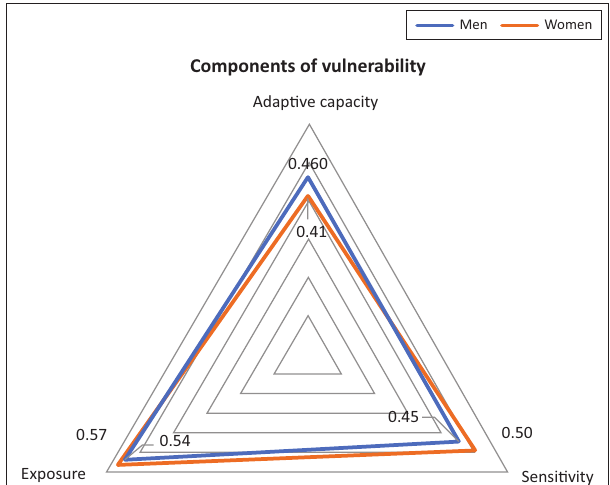
FIGURE 4: Triangle diagram showing the three contributing factors for vulnerability of